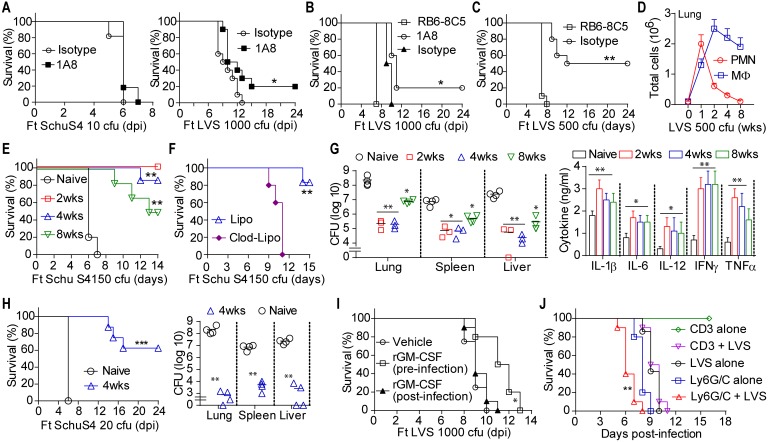
IMC/MDSC are associated with tissue damage and mortality during pulmonary tularemia.(A) Survival of LVS or SchuS4 infected mice depleted of myeloid cells. Ft-infected mice were treated with anti-Ly6G (clone 1A8) antibody or its isotype control antibody (200 μg/mouse/daily once) by intraperitoneal injection once daily between 2 to 4 dpi (% survival of two independent experiments, n = 10 mice, Log rank (Mantel-cox) test, *p<0.05). (B) Survival of LVS (1000 cfu/ lethal dose) infected mice depleted of myeloid cells. Mice were treated with RB6-8C5 antibody, 1A8 antibody or isotype control antibody (200 μg/mouse/daily once) by intraperitoneal injection at -1 (a day prior to infection), 2 and 4 dpi (% survival of two independent experiments, n = 10 mice, Log rank test, *p<0.05). (C) Survival of LVS (500 cfu/sub-lethal dose) infected mice depleted of myeloid cells. Mice were treated with RB6-8C5 antibody or isotype control antibody (200 μg/mouse/daily once) by intraperitoneal injection at -1 (a day prior to infection), 2 and 4 dpi (% survival of two independent experiments, n = 10 mice, Log rank test, **p<0.01). (D) Numbers of matured myeloid cells (PMN and macrophages) in lungs of sub-lethal LVS-infected survivor mice (mean ± SD of two independent experiments, Student’s t-test, *p<0.05, **p<0.01). (E) Survival of mice challenged with SchuS4 (150 cfu). Mice were first infected with sub-lethal LVS infection and those surviving mice were challenged with SchuS4 at 2, 4 or 8 weeks post-LVS infection and monitored for survival (% survival of two experiments, n = 6–10 mice, Log rank test, *p<0.05, **p<0.01). (F) Survival of mice challenged with SchuS4 (150 cfu). Mice were first infected with sub-lethal LVS infection and those surviving mice were treated with either clodronate-liposome or liposome vehicle alone at the end of 3rd week (2 days apart) and re-challenged with SchuS4 at the end of 4th weeks post-LVS infection for monitoring the survival (% survival, n = 6 mice/group, Log rank test, ***p<0.001). (G) Tissue bacterial burden and lung cytokines at 15 days post-SchuS4 challenge in surviving mice from experiments as shown in Panel E mean ± SD of two experiments, n = 4–6 mice, Student’s t-test, *p<0.05, **p<0.01). (H) Mice surviving sub-lethal LVS infection were challenged with 20 cfu of SchuS4 at 4 weeks post-LVS infection and monitored for survival and tissue bacterial burden was estimated at 36 days post-SchuS4 challenge (% survival or mean ± SD of 8 mice, Log rank test, **p<0.01, ***p<0.001). (I) Survival of LVS-infected mice treated with rGM-CSF. Either mice were treated intranasally with rGM-CSF (1 μg/mouse/daily once) pre-infection at -7, -5, -3, and -1 dpi or treated with rGM-CSF (2 μg/mouse/daily once) post-infection by intraperitoneal injection at 2 and 4 dpi (% survival of two independent experiments, n = 10 mice, Log rank test, *p<0.05 indicates the mean time-to-death between GM-CSF treated and untreated mice). (J) Adoptive transfer of Ly6G/C+ cells (isolated from lungs of LVS-infected mice at 6 dpi) or CD3+ T cells (isolated from spleen of naïve mice) into donor mice and monitored for survival following with and without subsequent LVS infection. The Ly6G and Ly6C fractions of myeloid cells were isolated from the lungs of LVS-infected donor mice (CD45.1) at 6 dpi (see methods) and equal numbers of these cells (2 x106 in 2 ml PBS) were mixed together and treated with antibiotic ciprofloxacin (100 μg/ml) for 45 min to kill cell-associated bacteria. After washing twice with PBS, cells were re-suspended in 50μl PBS and were transferred to naïve recipient mice (CD45.2) by intratracheal intubation. The CD3+ T cells were isolated from spleen of naïve mice and transferred to recipient mice as above. These mice were either infected with LVS on following day or left uninfected for monitoring the survival (% survival of two independent experiments, n = 10 mice, Log rank test, **p<0.01 indicates the difference between Ly6G/C + LVS group vs LVS alone group).